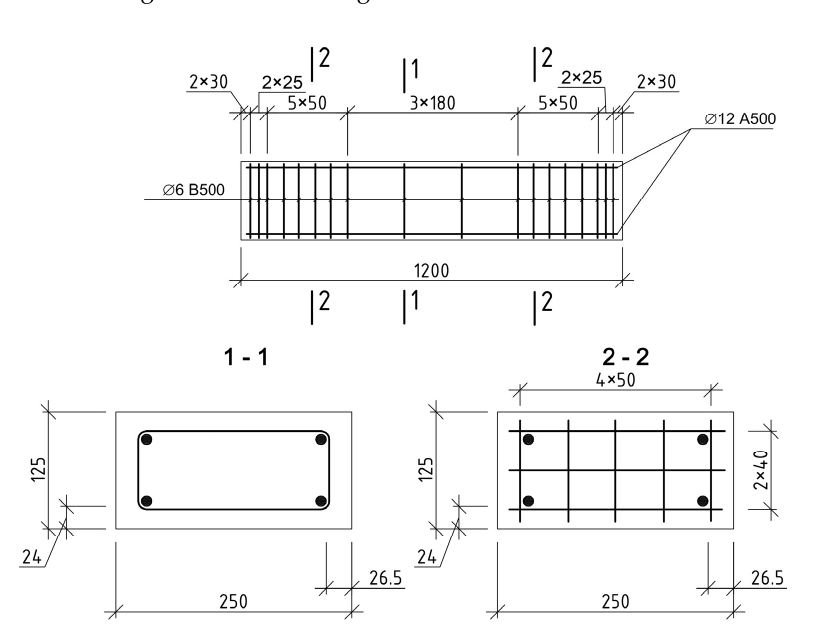
Figure 2. General view of the columns, prepared for reinforcement with stirrups and installation of end stirrups-anchors. To ensure three types of stress-strain state of the compressed elements, the load on the prototypes was transferred with a clearly fixed eccentricity through a specially de- signed steel head, which was bolted to the ends of the columns before testing. The design of the head is shown in Figure 3. This setup is designed to test samples for compression with eccentricity. Three slots were made on the end plates of the indicated heads, located along the geometric axes of the prototypes and at distances of 2.0 and 4.0 cm from them. The load from the press was transferred to the columns through trihedral steel knives with a leg of 70 mm installed in these slots, thereby creating three types of stress-strain state. This is conditionally central compression at a value of 0 / e h = 0 (samples of series A); elements